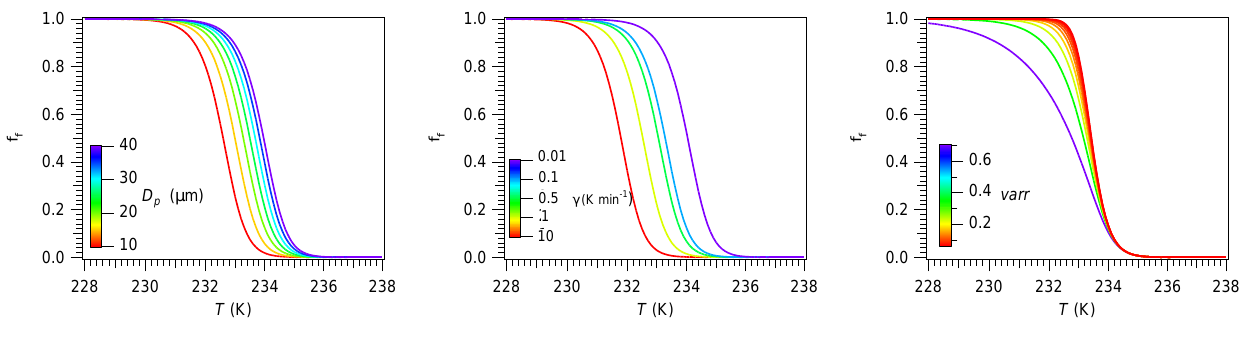
= 1Kmin − 1 , D p = 20 d t